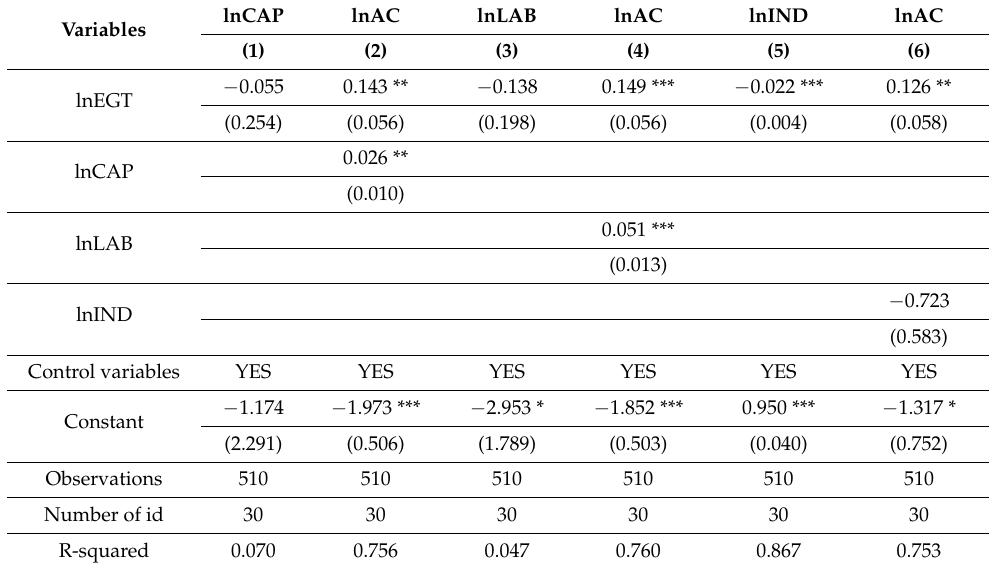
Table 7. Intermediary effect